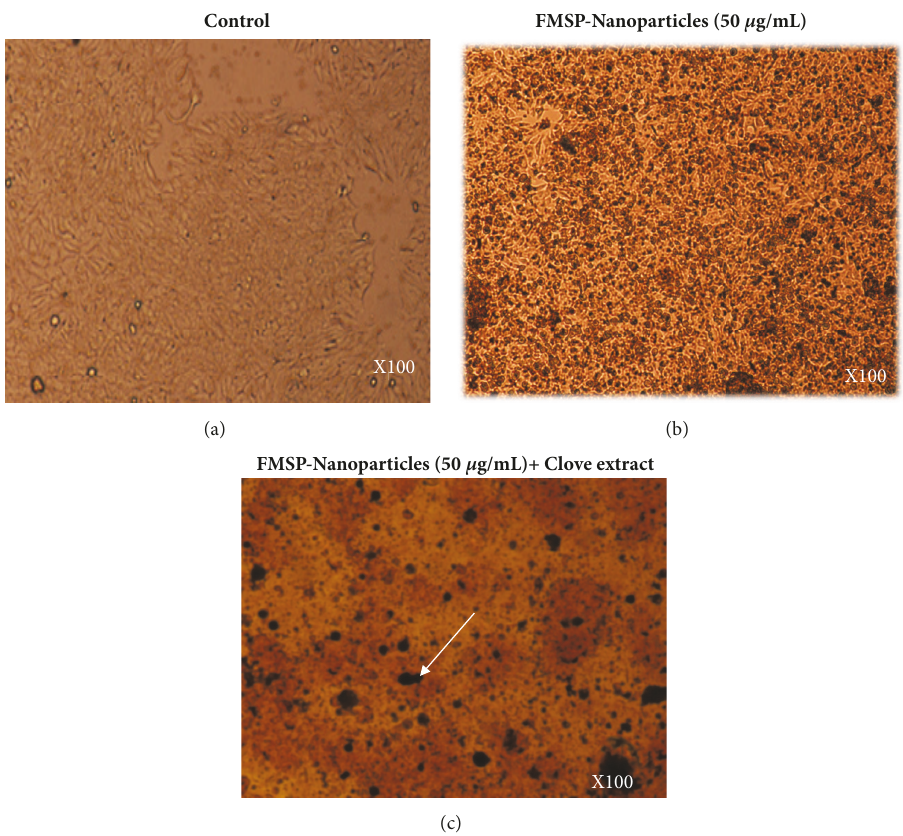
Figure 2: Cell morphology after treatment of FMSP-Nanoparticles alone: the MCF-7 cells were analyzed 48hrs posttreatment. Figure (a) is control; Figure (b) is treated with FMSP-nanoparticles (50 𝜇 g/mL); and Figure (c) is treated with FMSP-nanoparticles (50 𝜇 g/mL) + clove extracts (100 𝜇 g/mL). Arrows indicate cell dead cell debris. 100 x